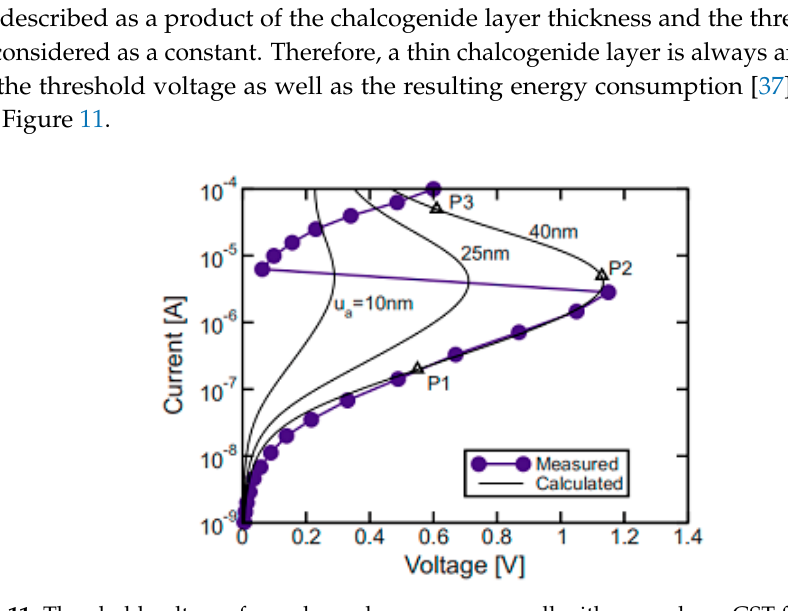
Figure 11. Threshold voltages for a phase-change memory cell with amorphous GST for three values of the thickness, namely u a = 10, 25, and 40 nm. Reprinted with permission from [37]. Copyright APS Physics, 2008.